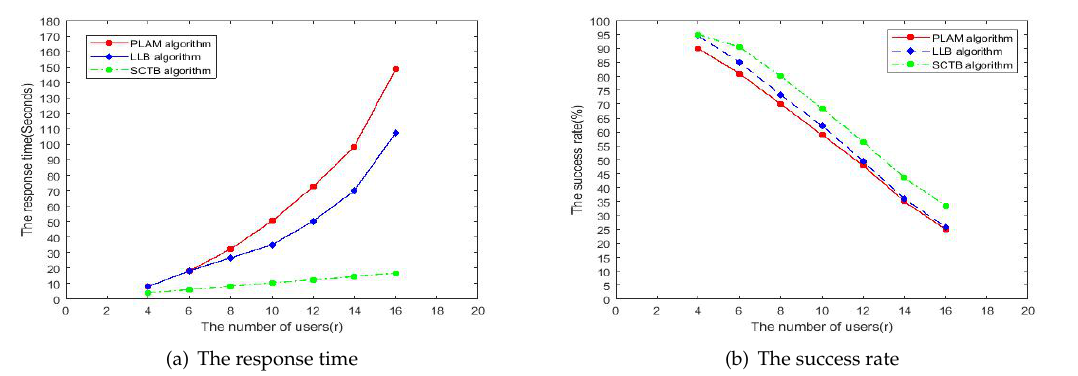
Figure 11. The simulation results for